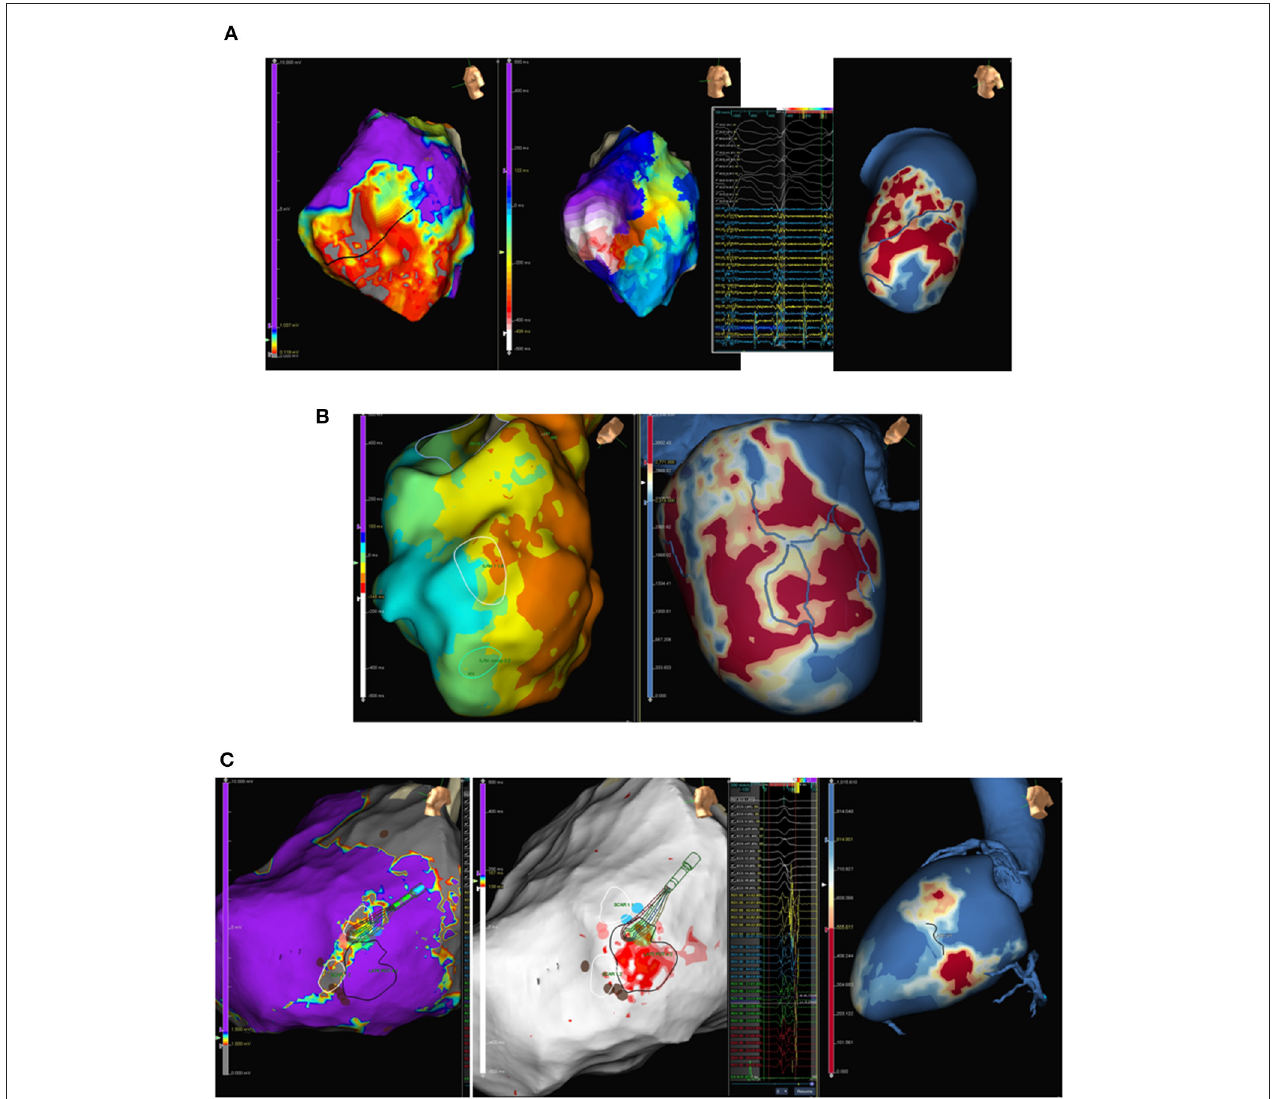
FIGURE 4 | Examples of correlation of three-dimensional pixel signal intensity (PSI) maps reconstruction from late gadolinium enhancement-cardiac magnetic resonance (LGE-CMR) (red: core scar, yellow: border zone, blue: healthy tissue: blue) with different electroanatomical (EAM) maps. (A) From left to right: EAM high density voltage map showing anterolateral scar (core scar: grey, border zone: red, healthy tissue: purple), ventricular tachycardia with a figure-of-eight circuit using border zone inside the scar (black line in the voltage map) with diastolic electrograms during ventricular tachycardia (VT); and PSI LGE-CMR map with clear conducting channel (blue line) at the same region as compared to the EAM voltage and activation map. (B) Left panel shows sinus rhythm isochronal activation map with an area of isochronal crowding (white circle) suggesting an area of deceleration zone. Right panel shows LGE-PSI map with an area of a very ramified channel (blue lines) inside a scar in the same area of deceleration zone in sinus rhythm EAM map. (C) Epicardial high density voltage map (left panel) and late potentials map (centre panel) with two small scars (right panel, grey area), intermediate tissue between scars, and area (red) of late potentials corresponding to border zone between scars. Right panel shows epicardial LGE-CMR PSI map (layer 80%) with the same two scars detected in the voltage